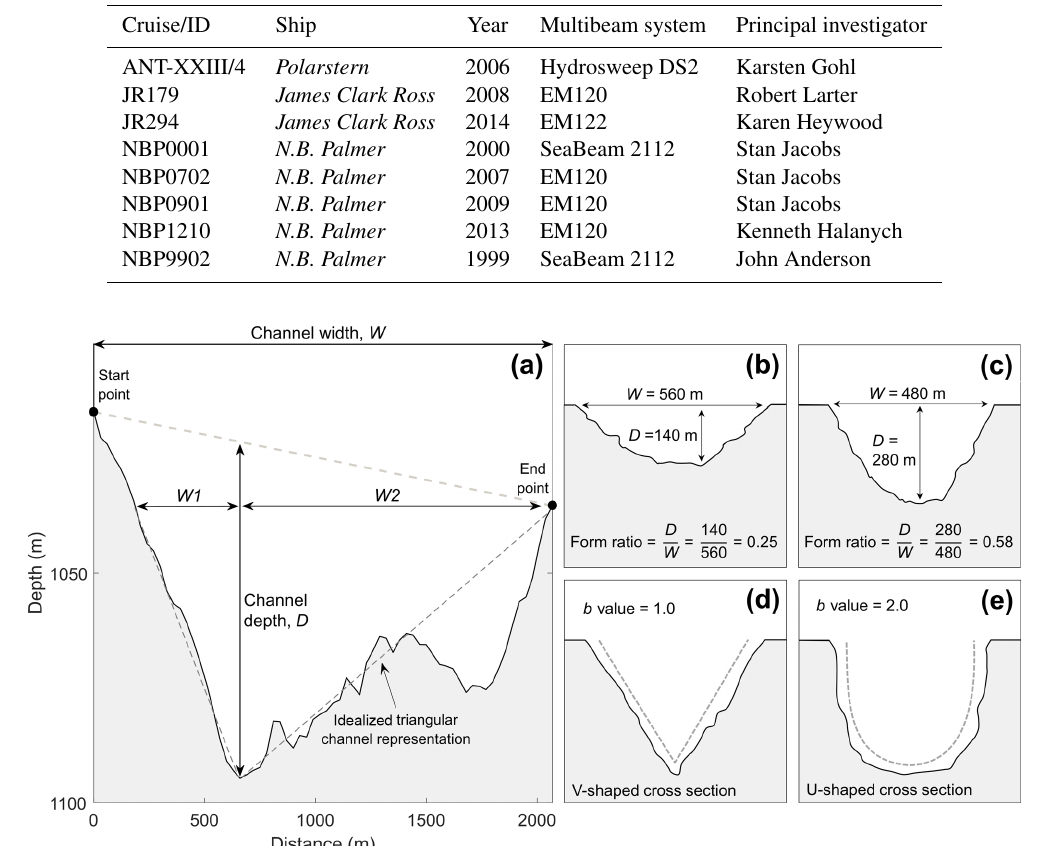
Figure 2. Methods of quantifying channel morphometry. (a) Output of the semiautomated algorithm used to derive channel cross-sectional metrics, after Noormets et al. (2009). Panels (b, c) illustrate the concept of channel form ratio: the ratio of channel depth to channel width. Wider, shallower channels will be characterized by lower form ratios. Panels (d, e) show the variation in channel b value according to channel shape. V-shaped channels will exhibit a b value of ∼ 1, whilst U-shaped channels will be characterized by b values of ∼ 2. Vertical exaggeration in (a) is 20 ×